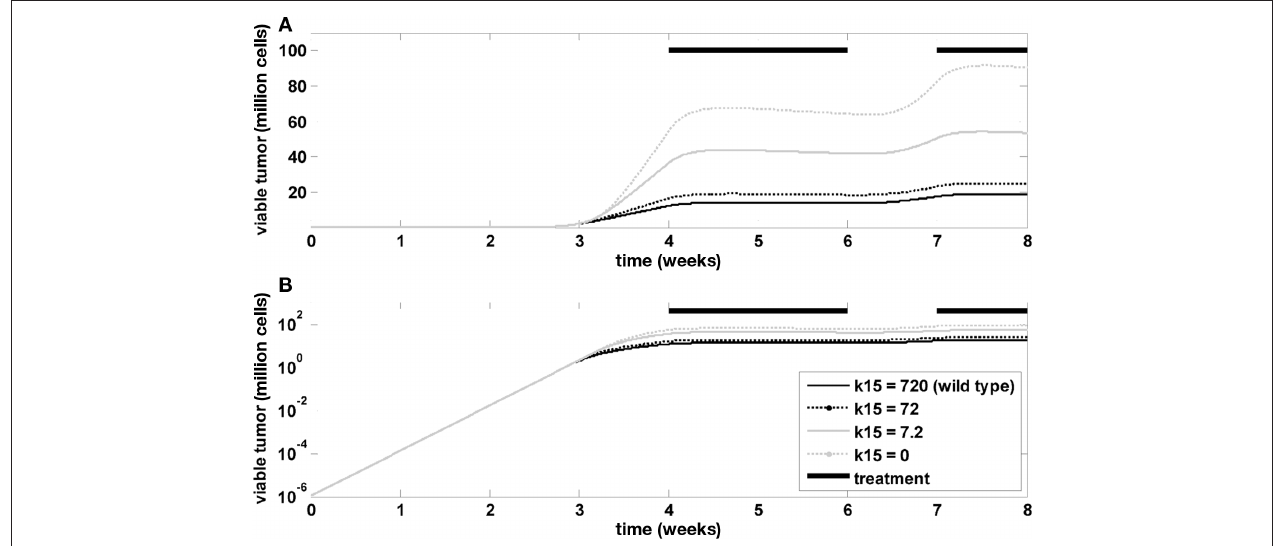
Figure 7 | influence of rAS mutation. Time course of viable tumor mass on a linear (A) and logarithmic (B) scale for different values of k15, which is the rate constant determining the inactivation kinetics of GAP-bound, RAS. Bi-daily treatment is indicated by thick black